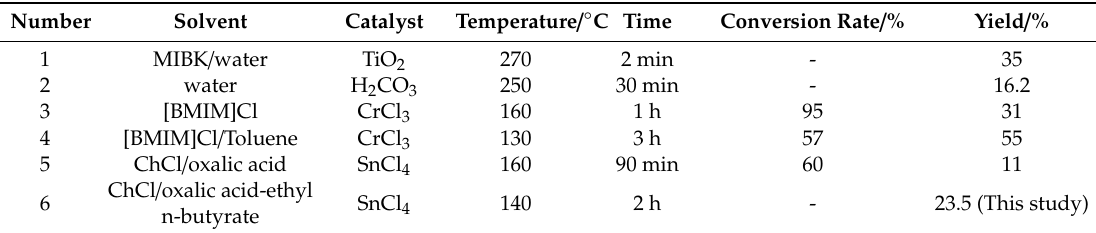
Table 3. The conversion of cellulose to 5-HMF in di ff erent